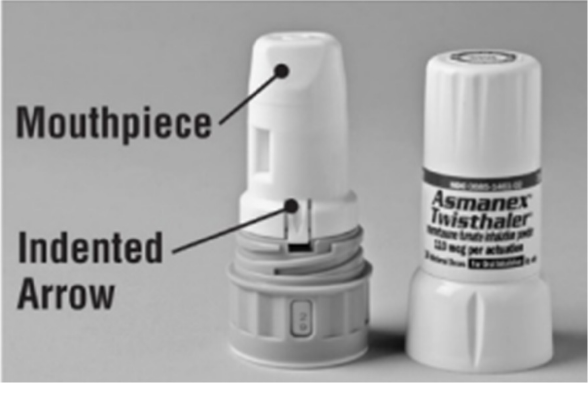
Figure 4. Asmanex ® Twisthaler ® [36].